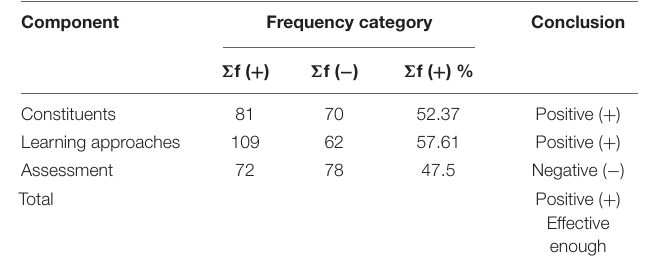
TABLE 3 | T -score analysis of the context variable component.